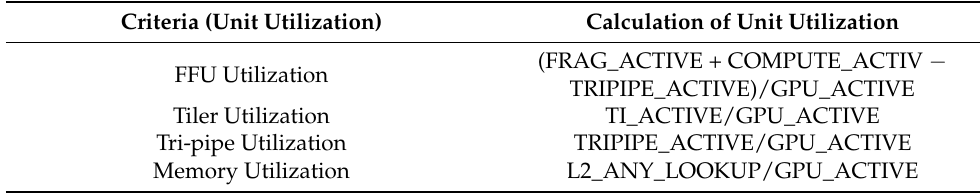
Table 4. GPU phase decision